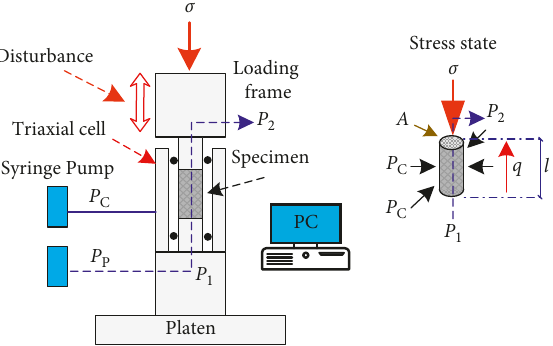
Figure 2: Permeability measurement apparatus.